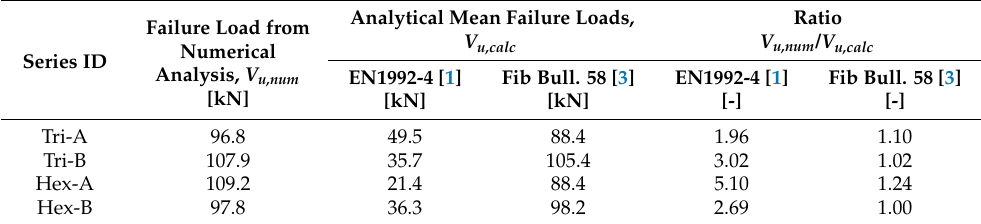
Table 2. Comparison of numerical results with analytically obtained failure loads for the investigated anchor groups loaded perpendicular to the